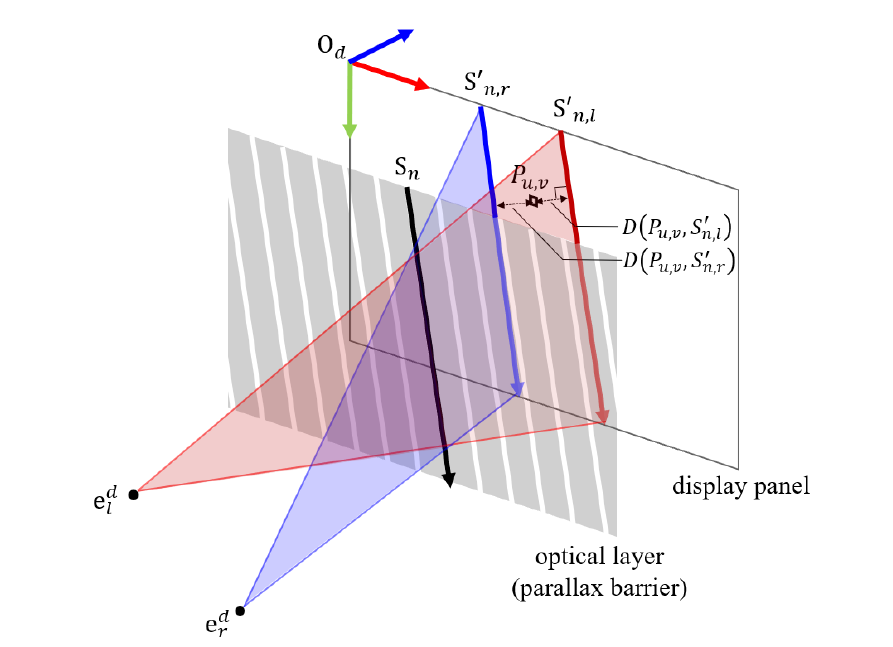
Figure 2. Overview of calibration process using the calibration module. The calibration module consists of a three-dimensional calibration pattern and an external camera.